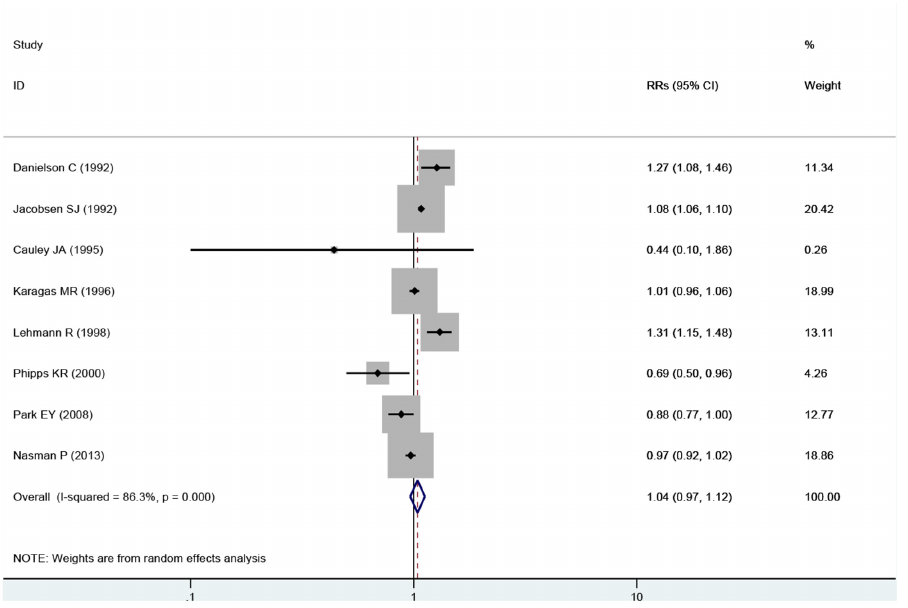
Fig 3. Forest plot of exposure to fluoride in the drinking water and hip fracture risk among women beyond 65 years. Studies are pooled with a random-effects